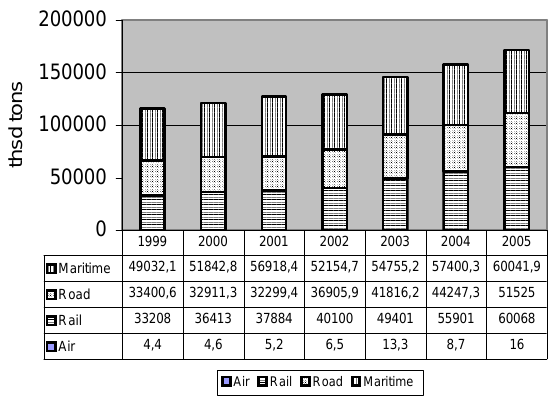
Fig 2. Distribution of the volume of cargoes by modes of transport in Latvia in the period of time from 1999 to 2005